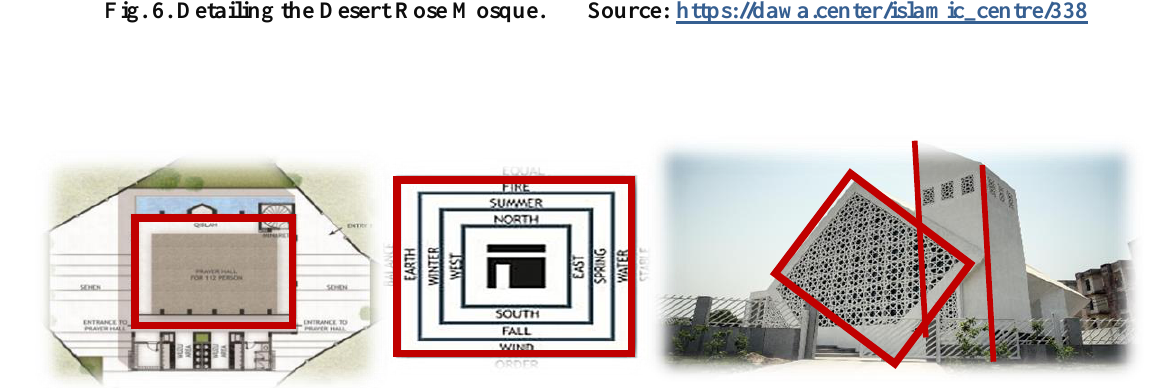
Fig. 7. The plan and details of a mosque in India,